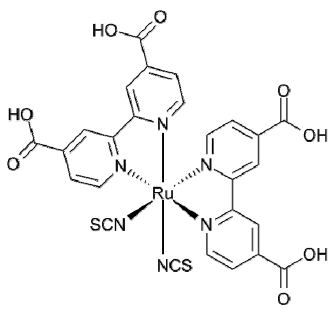
Figure 4. Molecular structure of the N3 dye.